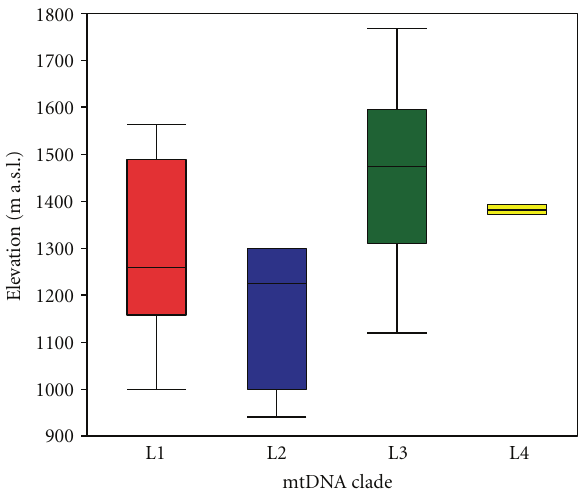
Figure 4: Altitudinal distributions of Myrmica kotokui clades in the Japanese Alps. The short horizontal line within each box denotes the median; the bottom and the top of each box denote the first and third quartiles, respectively, and the whiskers show the 5% and 95%